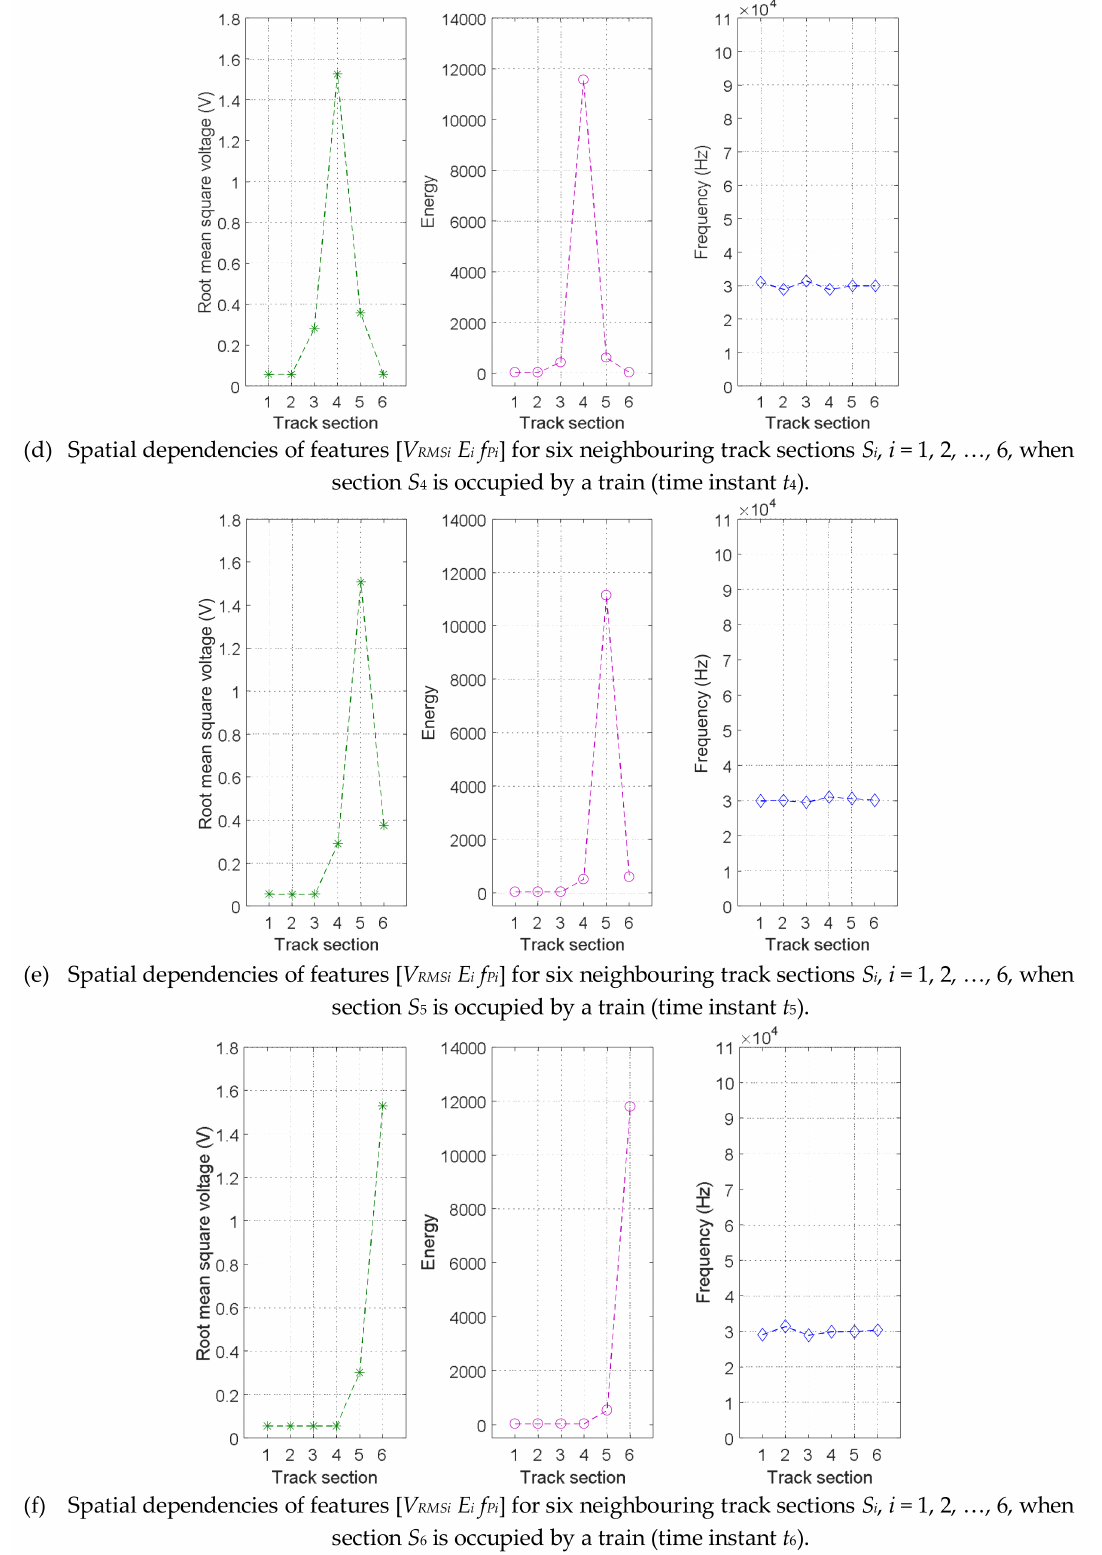
Figure 23. Spatial dependencies of features [ V RMSi E i f Pi ] for six neighbouring track sections S i , i = 1, 2, . . . , 6, in rail no. 2 when a train is moving through